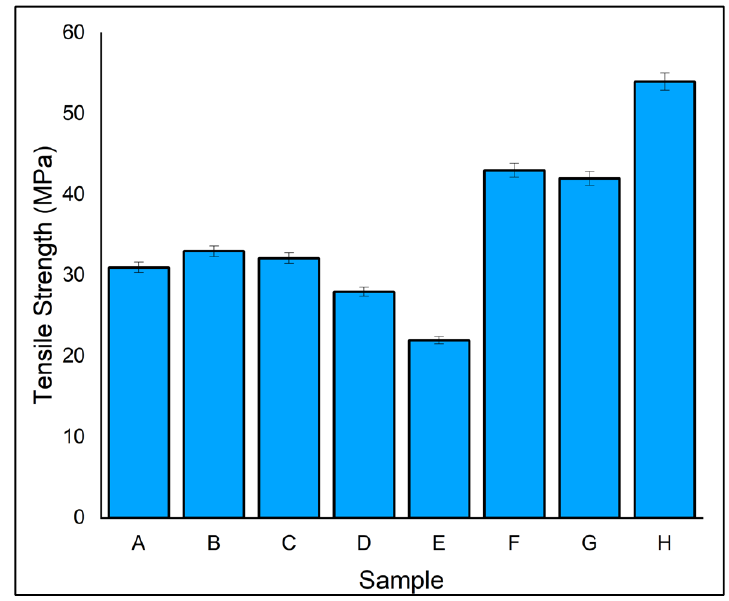
Figure 4. Tensile strength of